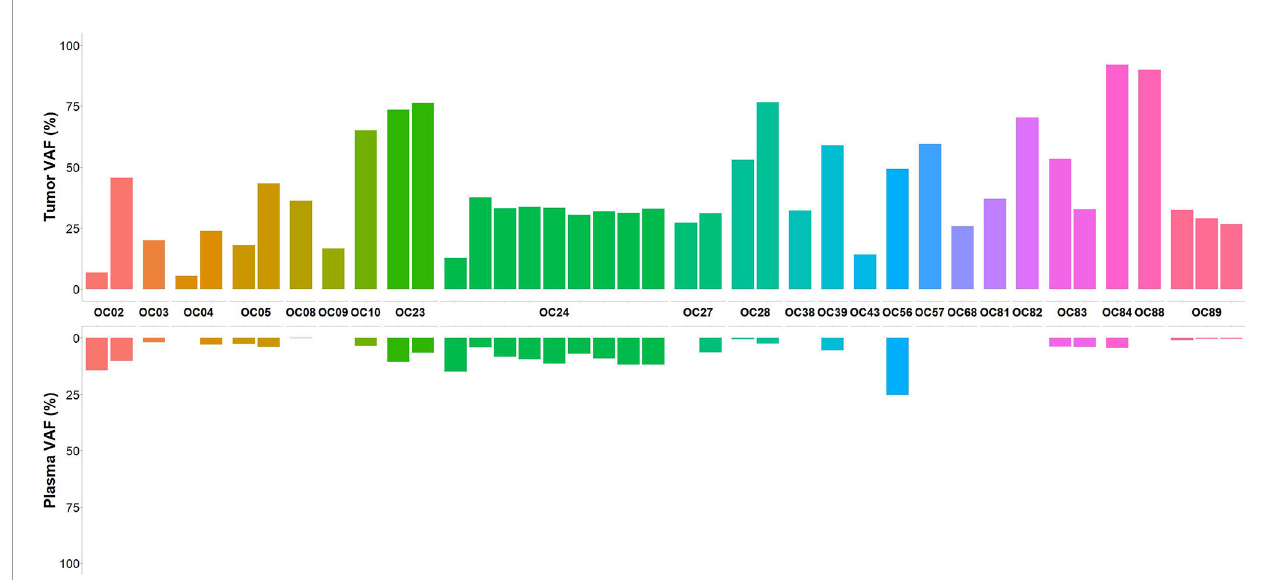
FIGURE 3 | Concordance of variants calls between tumor and plasma samples from the patient treatment naïve group. In patients with more than one somatic variant identi fi ed, the VAF for variants shared between matched tumor and plasma samples shows a concordance in hierarchy of VAF in three samples (OC05, OC28 and OC89).